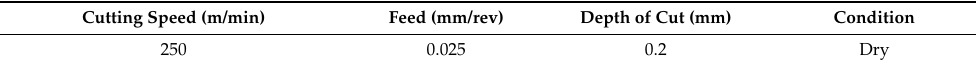
Table 3. Cutting parameters.